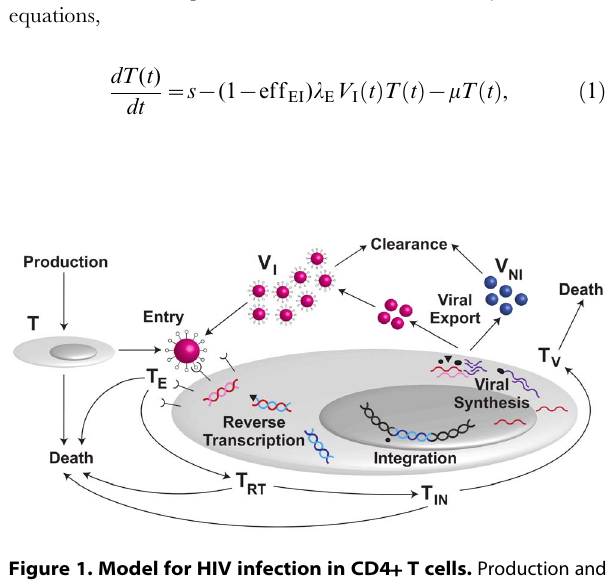
Figure 1. Model for HIV infection in CD4 + T cells. Production and loss includes CD4 + T cell production, CD4 + T cell death of infected and uninfected cells, and viral clearance. The major HIV infection stages in the model are: entry, reverse transcription, integration, and viral production. The model describes five types of CD4 + T cells: uninfected cells T , cells where HIV has passed entry T E , cells where HIV has passed RT T RT , cells where HIV has passed IN T IN , and productively infected CD4 + T cells T V . Virus comprises infectious virus V I , and non-infectious virus V NI (when PIs are administered).